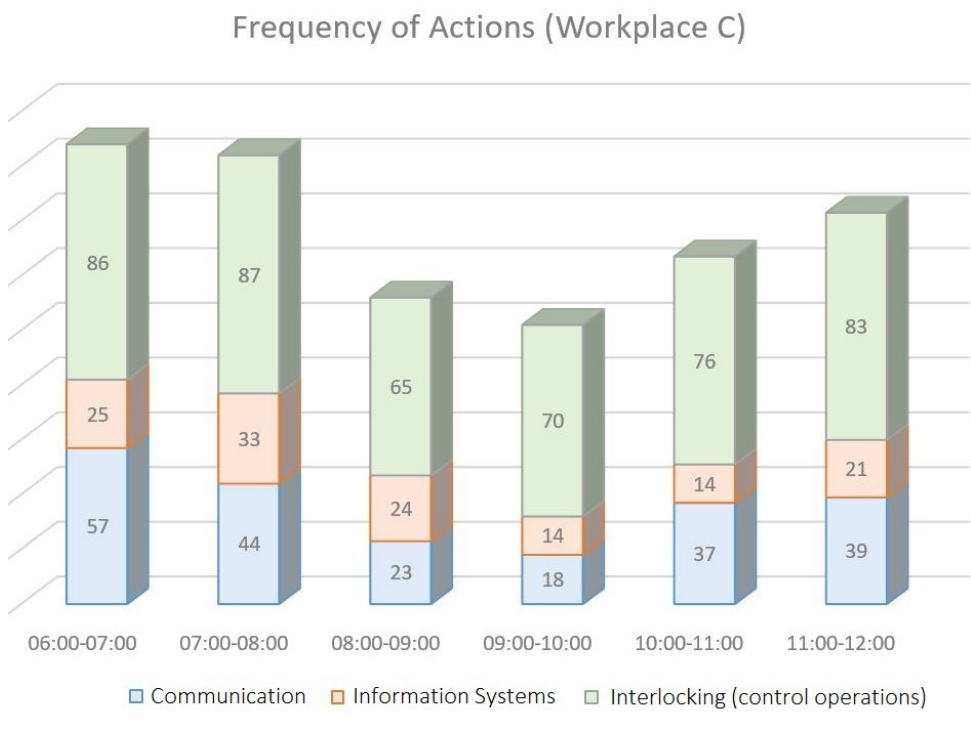
Figure 5. Frequency of actions distributed over time intervals at workplace C (period 06:00–12:00). Data processing showed the work commitment of operators during three given periods (Table